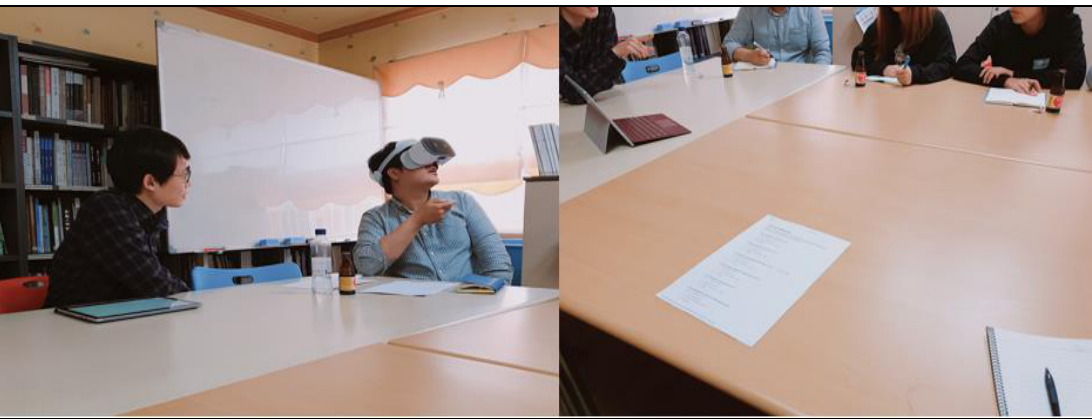
Figure 11. Photos of heuristic evaluations.